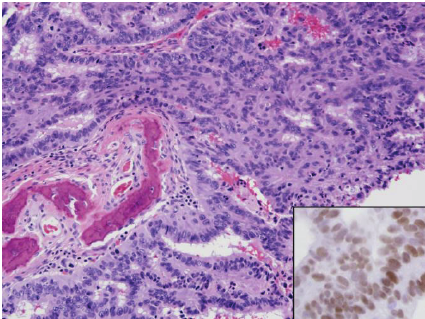
Figure 4: Metastatic adenocarcinoma involving trabecular bone (H&E, 200x), with (inset) immunoperoxidase staining of tumor for CDX-2